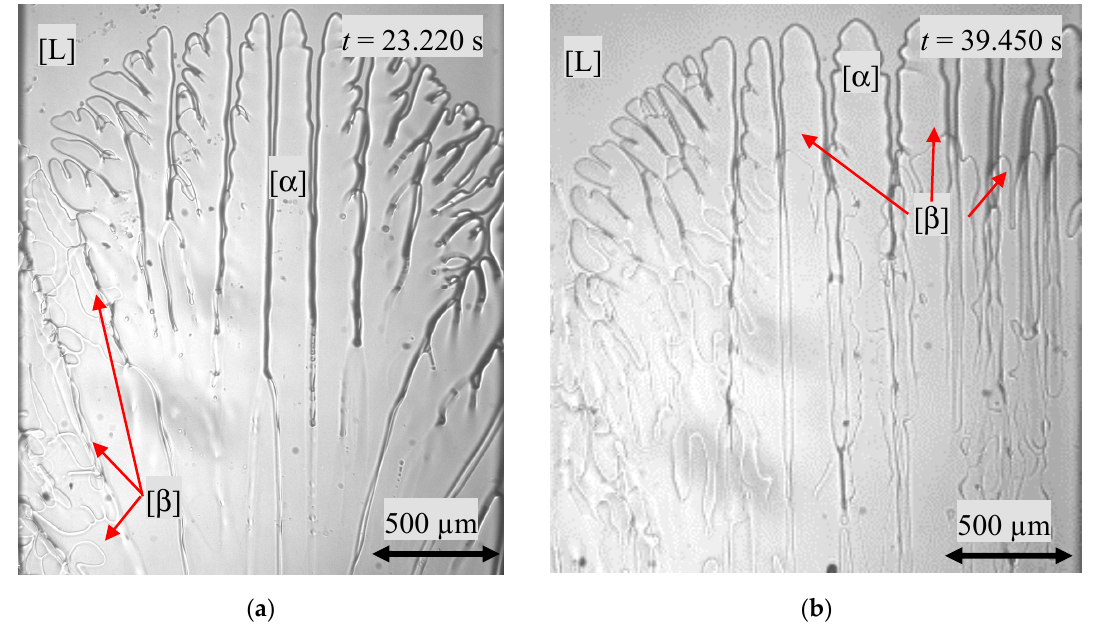
Figure 4. Solidification morphology for a hypo-peritectic sample with x = 0.473 ( a ) nucleation event at the left side of the image and ( b ) simultaneous growth of both phases in a dendritic/cellular manner. The images show a width of 2.000 μ m.